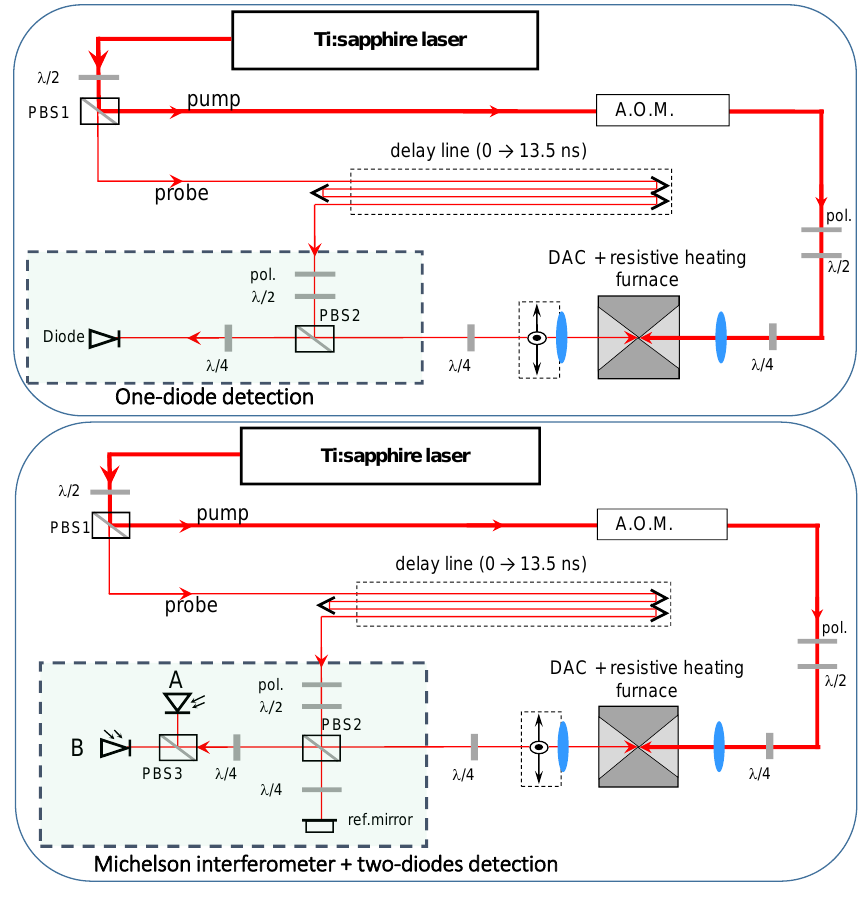
( Top ) Schematic [19] of the diamond anvil cell (DAC)/picosecond acoustics setup (transmission geometry) within the reflectometry configuration (one diode detection). ( Bottom ) Interferometric setup (both the real and imagery part of the reflectivity are measured using a Michelson interferometer). PBS: polarizing beam-splitter, λ /4: quarter wave plate, λ /2: half-wave plate, pol.: linear polarizer, A.O.M.: acousto-optic modulator. A and B: